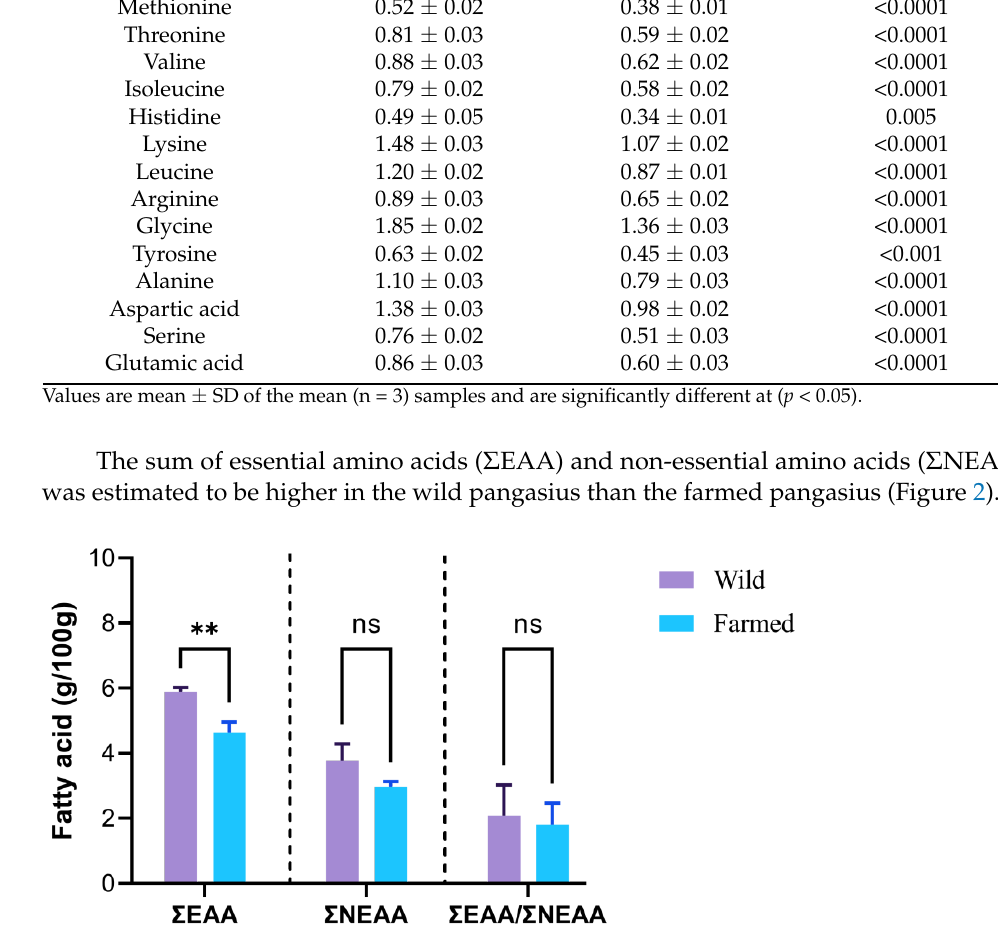
Figure 2. Total essential amino acids ( Σ EAA), non-essential amino acids ( Σ NEAA), and the ratio of Σ EAA/ Σ NEAA compounds in g/100 g in the wild and the farmed pangasius. Data were subjected to multiple unpaired t -test and significant level was set at p < 0.05. Asterisks (**) indicate significant difference and ns, non-significant.